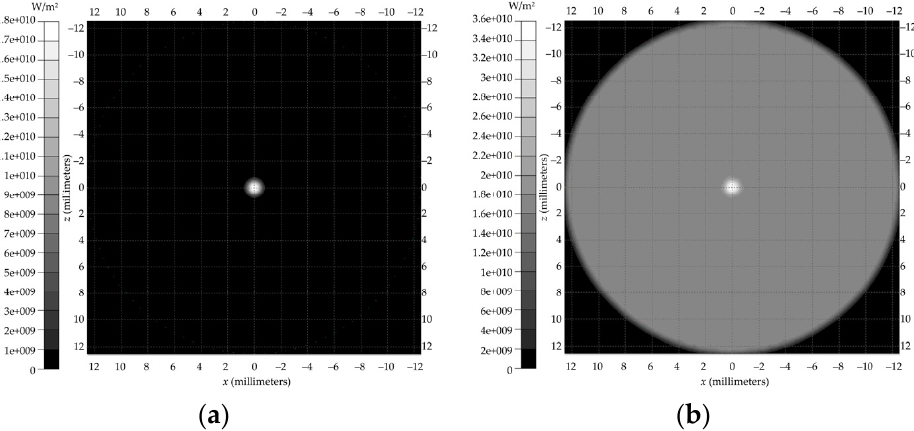
Figure 4. Simulation results of aiming-and-positioning system with and without light-emitting diode (LED) ambient light: ( a ) without LED and ( b ) with LED.